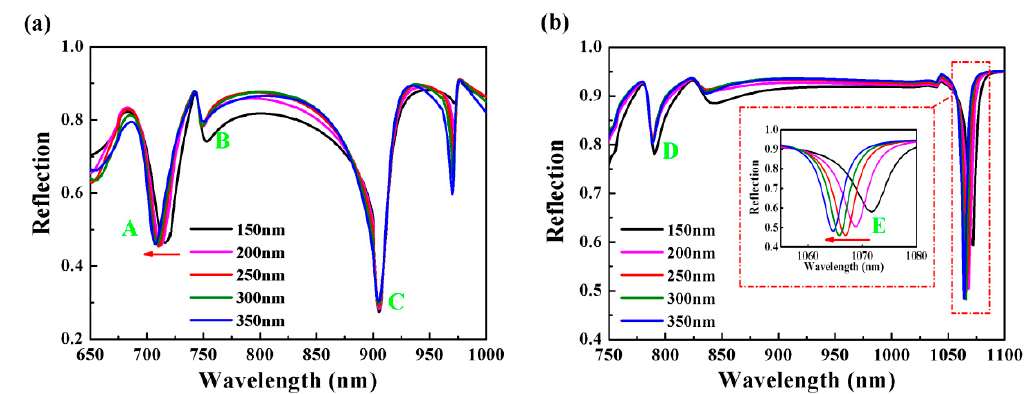
Figure 2. Reflection spectra for different thickness of polymethyl methacrylate (PMMA) g with incident angle ( a ) θ = 65° and ( b ) θ = 30°.